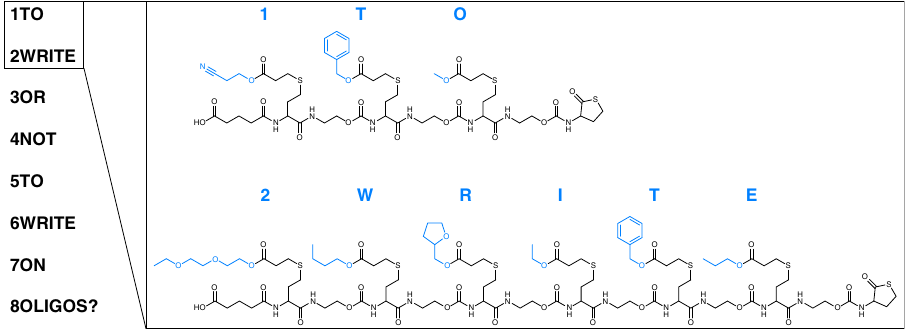
Fig. 3 Writing a sentence with sequences. The fi rst two words of the question '1TO 2WRITE 3OR 4NOT 5TO 6WRITE 7ON 8OLIGOS?' in their chemical form. The different functionalities (in blue), introduced via acrylates in the chemical protocol, express a different letter or